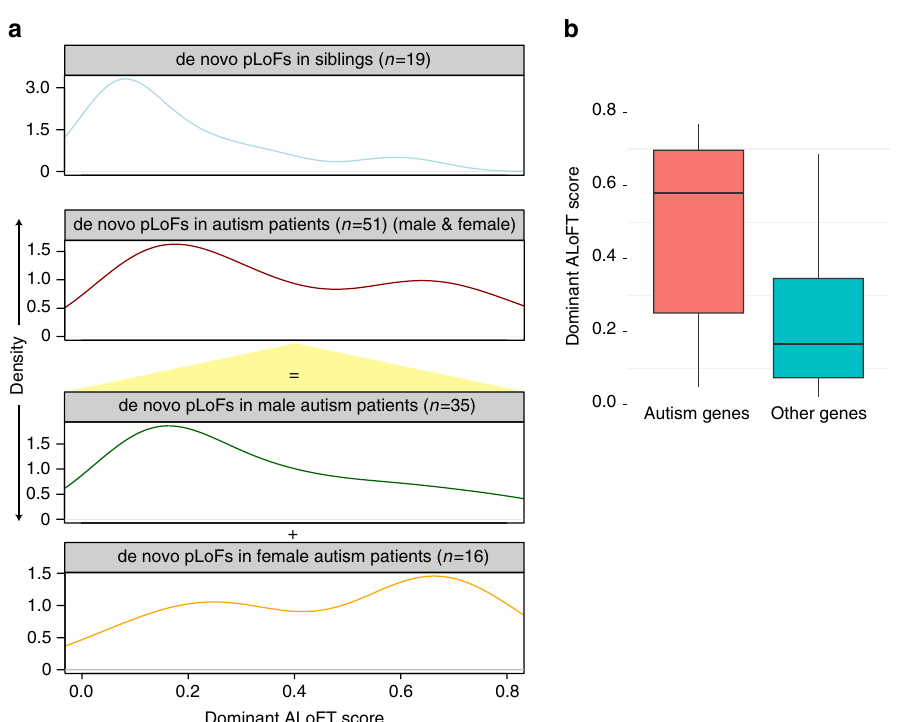
Fig. 3 ALoFT classi fi cation of de novo premature stop variants from autism studies. a The top two panels show the ALoFT dominant scores of de novo premature stop mutations in autism patients and siblings; mutations in patients are further separated by gender, as shown in the bottom two panels. b ALoFT dominant prediction scores for autism de novo pLoFs in con fi dent risk genes. In this plot, the center line represents the median value of the data, the box goes from the fi rst quartile to the third quartile. The lower whisker goes from Q1 to the smallest non-outlier in the data set, and the upper whisker goes from Q3 to the largest non-outlier in the data